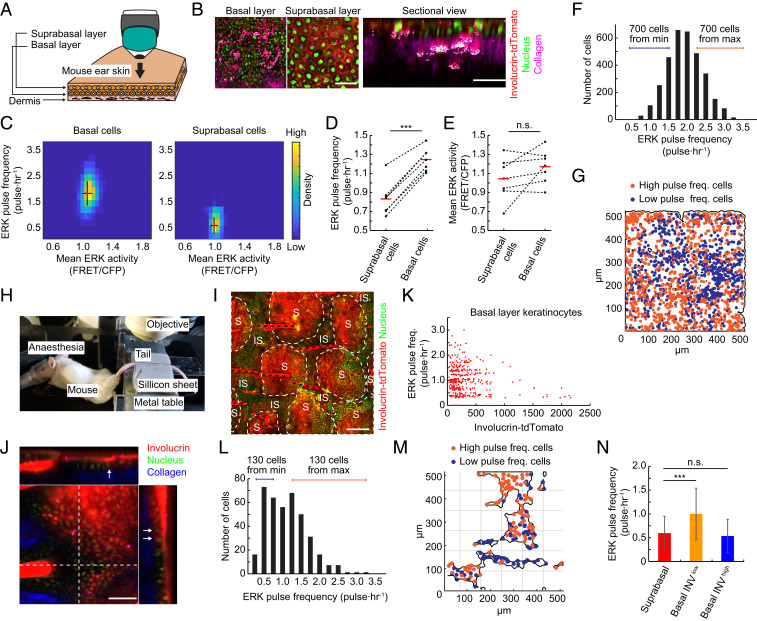
ERK pulse activity is observed in live mouse epidermis. (A) Schematic of in vivo observation of mouse epidermis. Ear skin of mouse epidermis expressing EKAR-EVnls and Involucrin-tdTomato was observed by multiphoton microscopy. (B) Representative images of epidermis in mouse expressing EKAR-EVnls and Involucrin-tdTomato. Collagen (magenta) was visualized by SHG microscopy. Sectional view image was reconstructed from z-stack images. (Scale bar: 100 μm.) (C) A 2D histogram of ERK pulse frequency and mean activity in basal (Left) and suprabasal (Right) layer cells. Mean and SD are shown by red dots and black lines, respectively (n = 3,238 basal cells and 352 suprabasal cells). (D and E) ERK (D) pulse frequency and (E) mean activity in the basal and suprabasal layer cells of seven mice. Mean is shown by red bars. (F) Distribution of ERK pulse frequencies of cells in the basal layer of mouse ear skin (n = 3,238 cells). (G) Mapping of basal layer keratinocytes showing the 700 least pulsatile (blue) and 700 most pulsatile (orange) cells, as indicated in F. (H) In vivo imaging of mouse tail epidermis. The anesthetized mouse was placed on a heated pad, and the tail was immobilized between soft silicon gum sheets. (I) Projection XY view of tail epidermis of mouse expressing EKAR-EVnls and Involucrin-tdTomato. S: scale epidermis; IS: interscale epidermis; black dotted lines: hair. (Scale bar: 200 μm.) (J) Orthogonal views of tail epidermis of mouse expressing EKAR-EVnls and Involucrin-tdTomato. Arrows indicate basal layer cells expressing Involucrin. (Scale bar: 100 μm.) (K) Dot plot of ERK pulse frequency and Involucrin-tdTomato expression in individual cells (n = 391 cells). (L) Distribution of ERK pulse frequencies of cells in the basal layer of mouse tail skin (n = 391 cells). (M) Mapping of basal layer keratinocytes showing the 130 least pulsatile (blue) and 130 most pulsatile (orange) cells as indicated in L. (N) Mean ERK pulse frequencies in the indicated tail epidermal cells. Data are mean ± SD (n = 318, 374, and 19 cells). Statistical significance was examined by two-tailed unpaired Student’s t test; P values are indicated by ***P < 0.001, n.s. = not significant (P > 0.05).